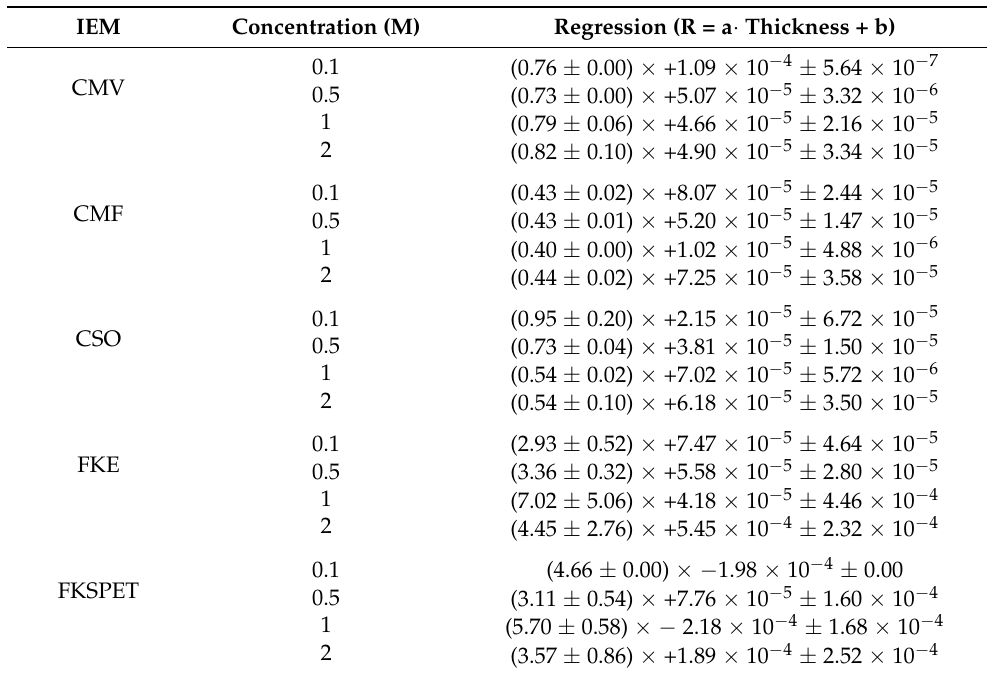
Table A2. CEMs at 298